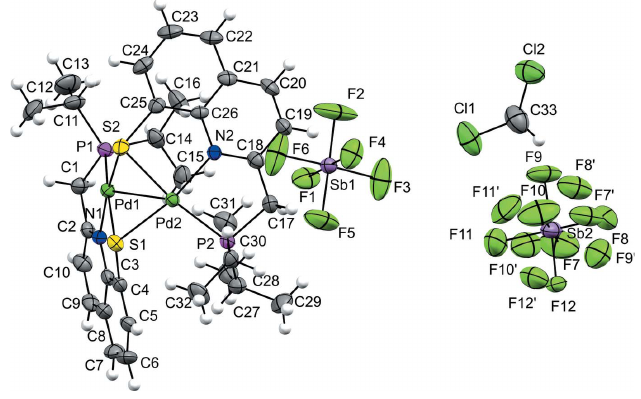
Figure 2 The molecular structure of the title compound with the atom numbering. Displacement ellipsoids are drawn at the 50% probability level.